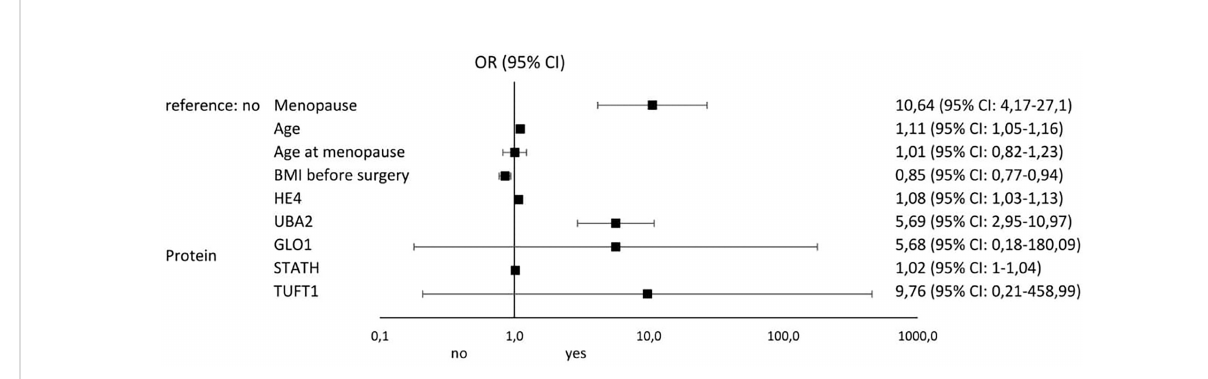
FIGURE 5 Results of univariable logistic regression analysis - odds ratio (OR) and its 95% con fi dence interval (95% CI) for the relationship between the occurrence of cancer (no/yes) and the particular classi fi cation variables of all patients in the study groups (A, B, and